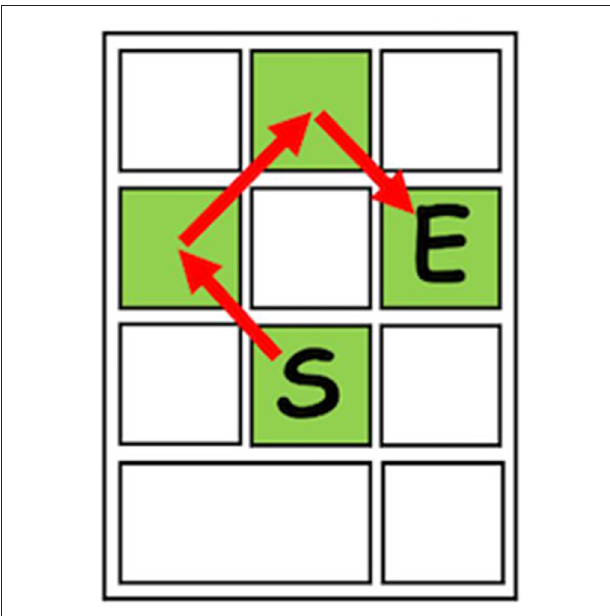
FIGURE 1 | Diagram depicting the sequence of keys used in the experimental task (S, start key; E, end